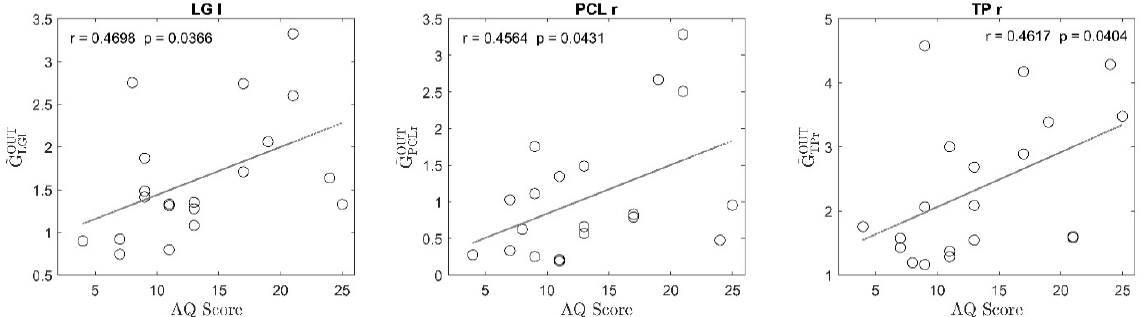
Figure 1. Plot of the regression lines between the sum of the normalized connections exiting from a given region (output sum (cid:102) GC (cid:3016)(cid:3022)(cid:3021) ROI i ) and the Autism Spectrum Quotient (AQ) score, obtained using data from the 20 participants. Only plots in the three regions that exhibit a correlation coefficient higher than 0.4, with a significant p value for the correlation and significant difference between the two classes, are shown. For each plot, the regression coefficient and the p value for testing the hypothesis of no-correlation are shown in the label. It is worth noting that to obtain these plots, the connection matrix for each participant was normalized so that the total sum of connection strength was as high as 100 (see Equations (4)–(6)); hence, for example, a value of 3 on the y ‐ axis indicates that 3% of the total connections in the network are exiting from that particular ROI. Hence, the values in these plots reflects whether the connections leaving the ROI are stronger (high value) or weaker (low value) compared to the total sum of the connections in the same subject.